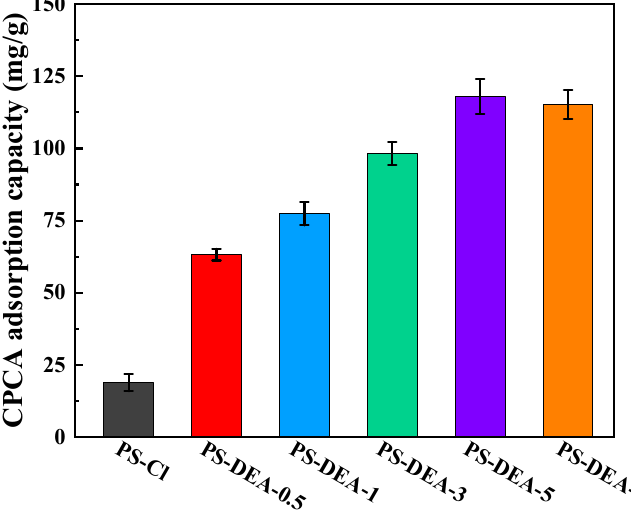
Figure 5. Adsorption capacity of PS − DEA − x on CPCA.